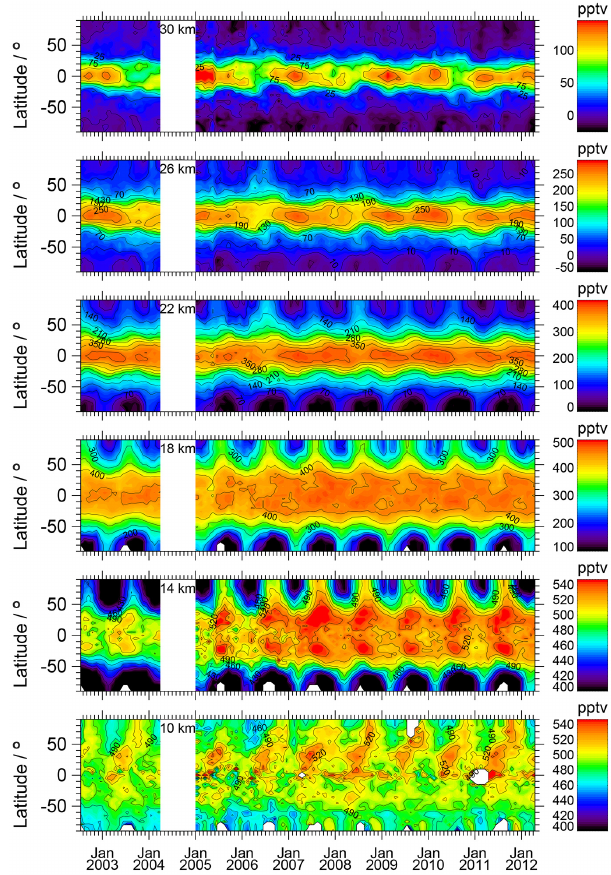
Figure 6. Time series of monthly and zonally averaged OCS mea- sured by MIPAS at 30, 26, 22, 18, 14 and 10km (top to bottom). The white area in 2004 is a data gap due to operational shutdown of MIPAS and the remaining white areas are caused by cloud con- tamination. Note the different colour ranges. Values outside of the colour ranges are also labelled in black or red,